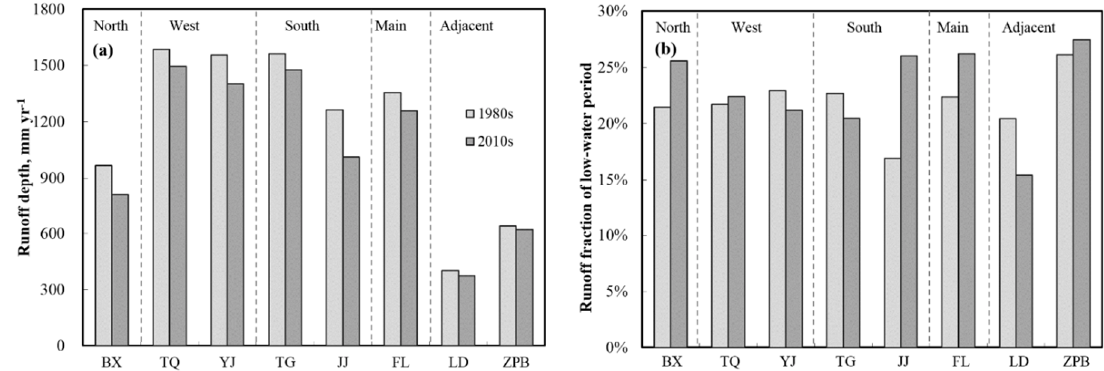
Figure 4. The changes in runoff depth during the high-flow and low-water periods ( a ) and the contribution of the low-water period ( b ) in the QYJ sub-basins and adjacent basins from the 1980s (1974–1987) to 2010s (2007–2013).